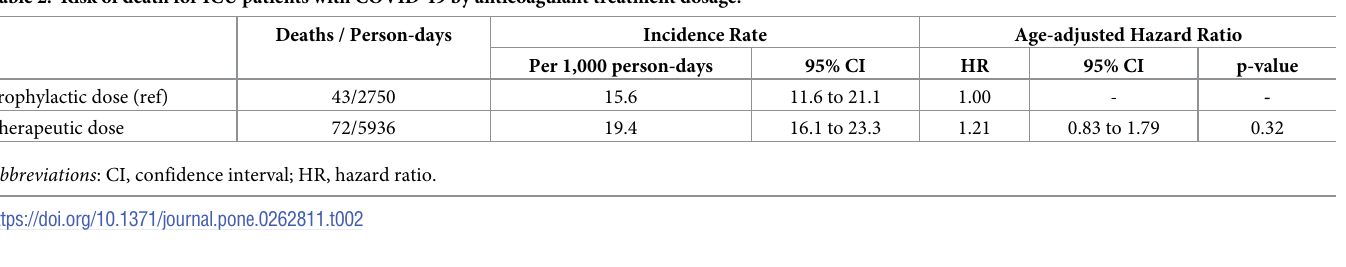
Table 3. Risk of death for COVID-19 patients with 3 or more weeks ICU admission by anticoagulant treatment dosage. Deaths / Person-days